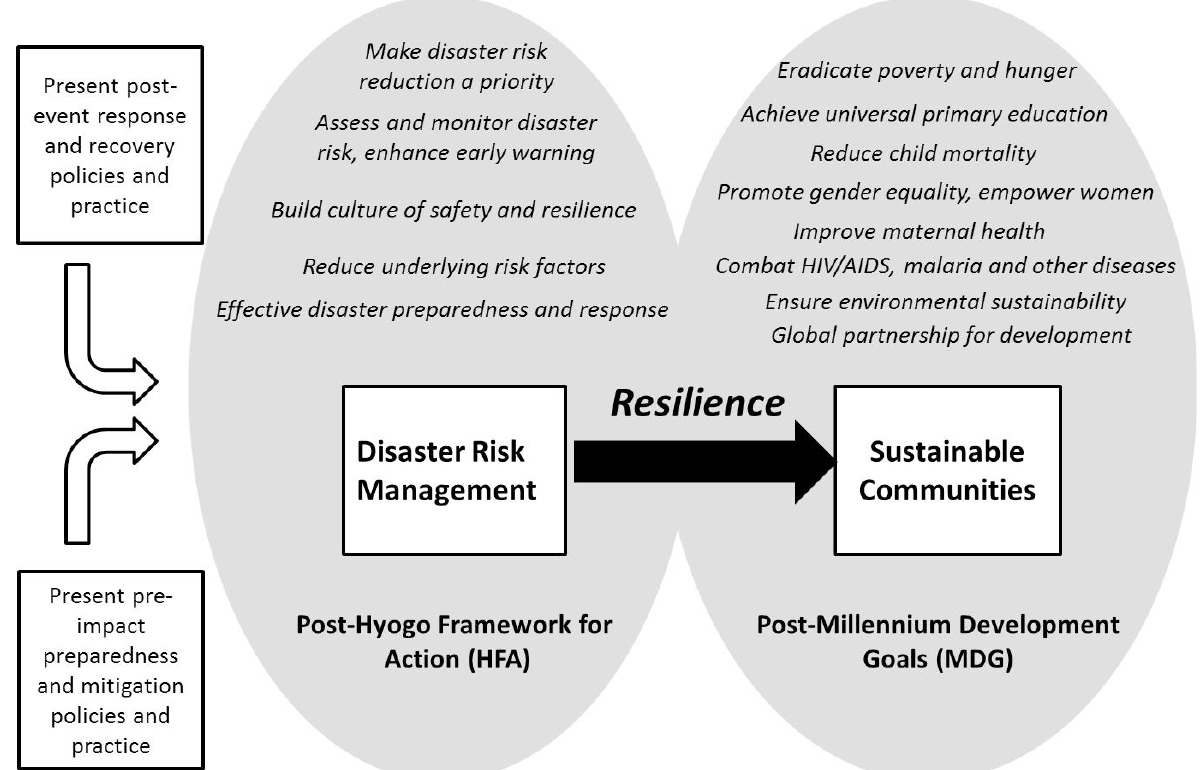
Figure 1. The path to a disaster resilient